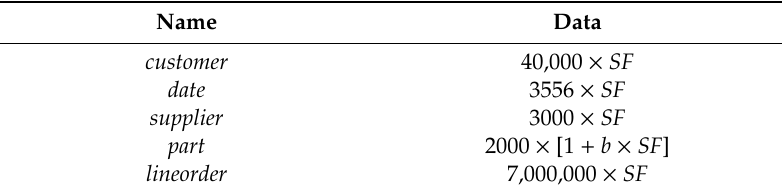
Table 2. Experimental